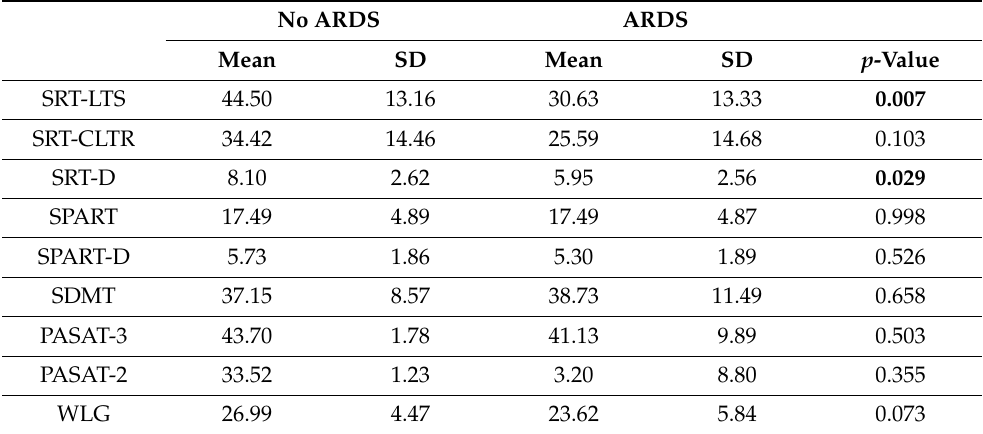
Table 4 : Neuropsychological scores in patients with Acute Respiratory Distress Syndrome (ARDS) and patients without it (No ARDS).